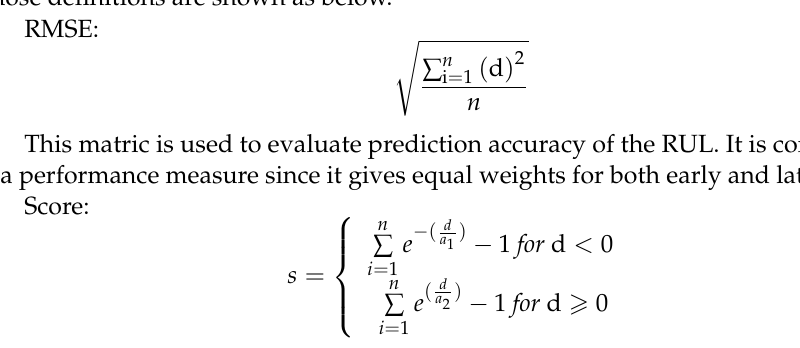
Table 3. Commercial Modular Aero-Propulsion System Simulation (C-MAPSS) dataset details. Dataset